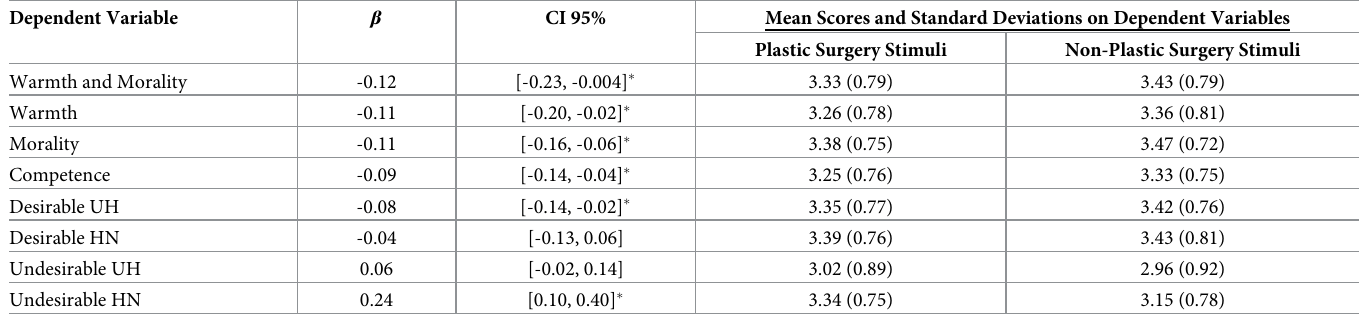
Table 1. The effect of plastic surgery on person perception (i.e. ‘negative plastic surgery effect’).